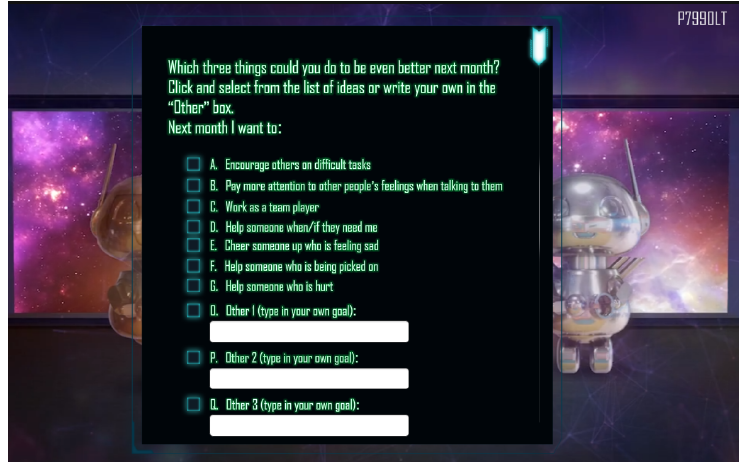
Figure A5. Goal setting activity.